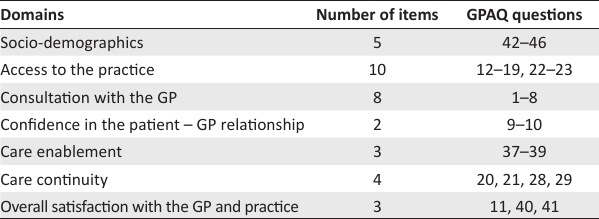
TABLE 1: Relationship of General Practice Assessment Questionnaire questions to key domains of service delivery.